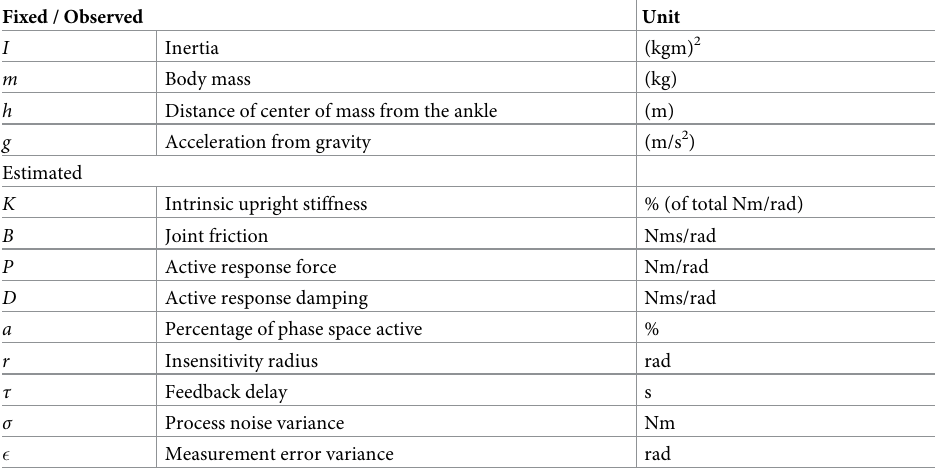
Table 1. Parameters of the IPC model with units and